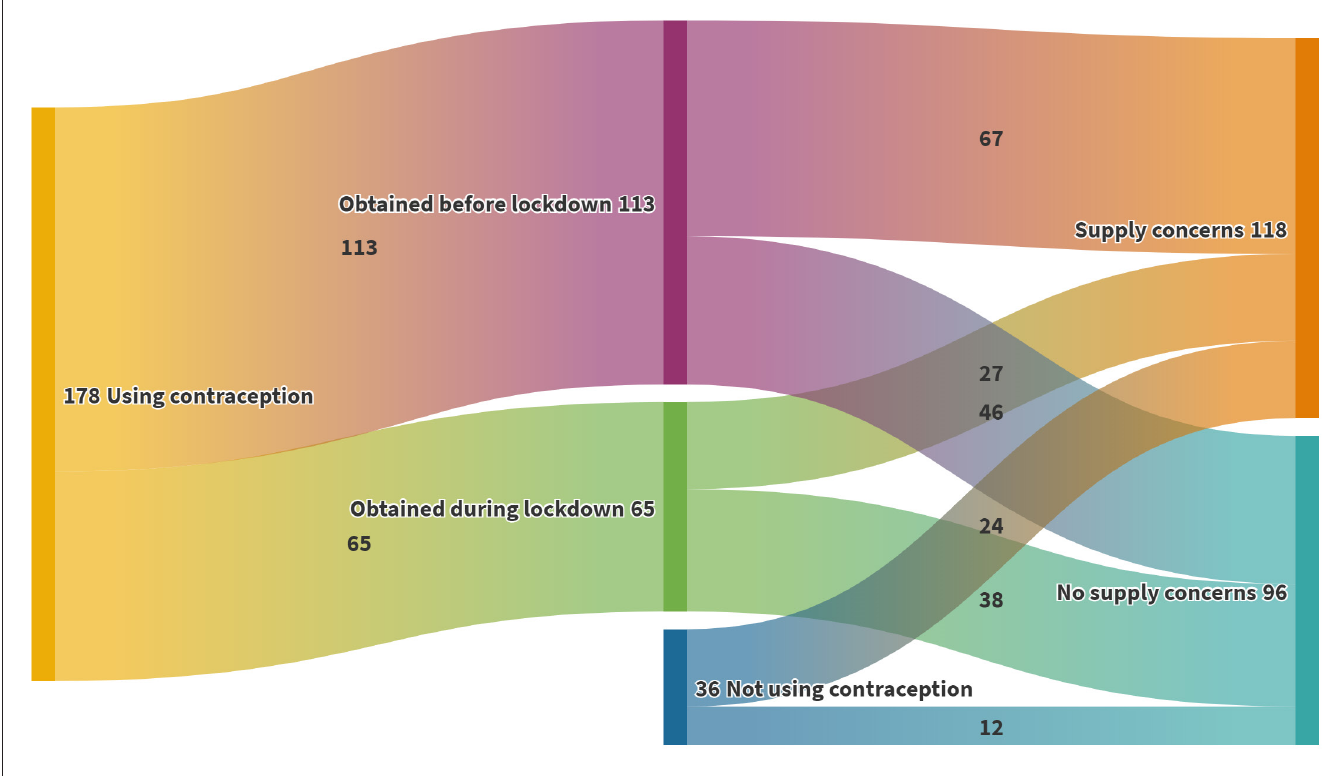
Figure 2 Sankey diagram summarising concerns about contraceptive supplies among the three groups of responders: those using contraception obtained before or during lockdown, and those not using but were seeking a